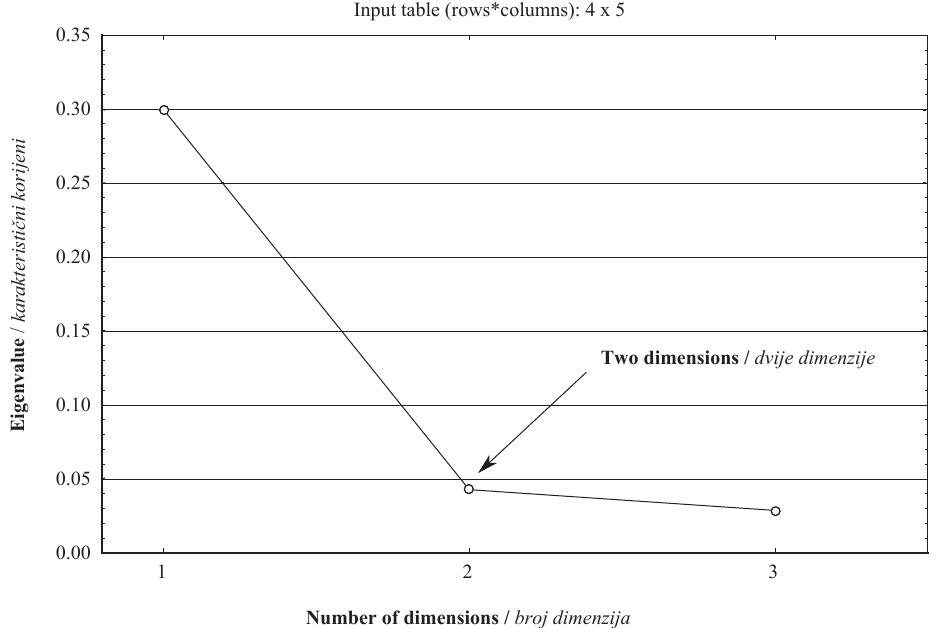
Figure 7 Scree plot for variables: size of company and educational background of individuals designing furniture Slika 7 . Scree plot za varijable: veli č ina tvrtke i obrazovanje pojedinaca koji dizajniraju